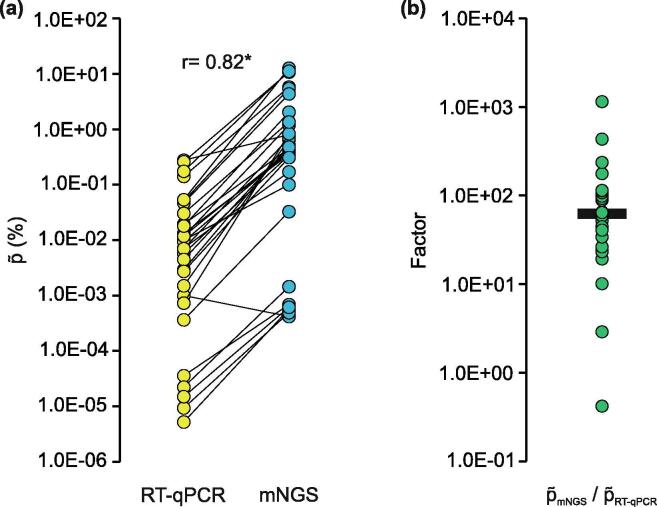
Comparison of RT-qPCR and mNGS derived virus to background ratios. (a) p∼ were determined by mNGS analysis (proportion of virus reads to total reads) and absolute quantification by RT-qPCR (proportion of virus RNA in ng/µl to the total RNA concentration); r = 0.82, **p < 0.0001. (b) Discrepancy of mNGS and RT-qPCR derived p∼ displayed as the factor of p∼mNGS / p∼RT-qPCR; median = 61.7.